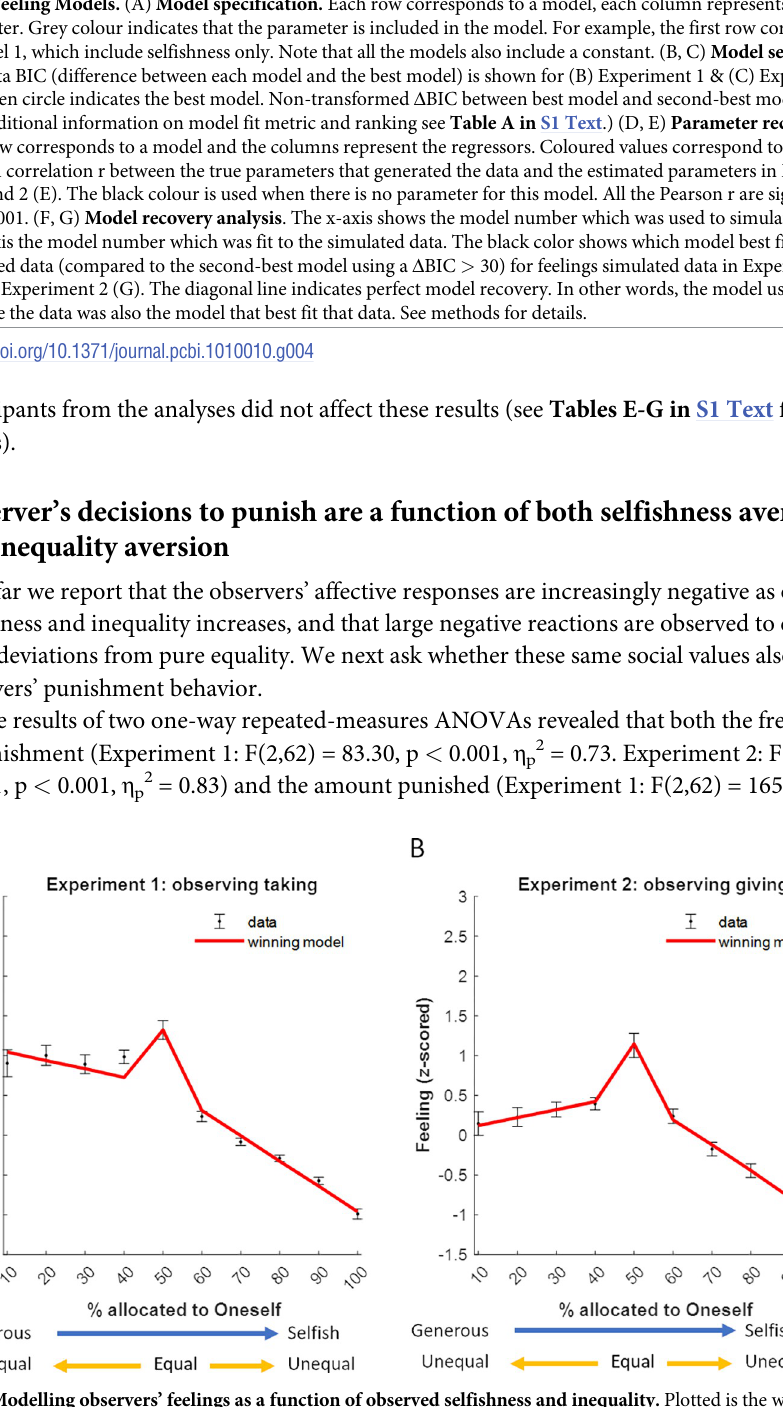
Fig 4. Feeling Models. (A) Model specification. Each row corresponds to a model, each column represents a parameter. Grey colour indicates that the parameter is included in the model. For example, the first row corresponds to model 1, which include selfishness only. Note that all the models also include a constant. (B, C) Model selection. Log delta BIC (difference between each model and the best model) is shown for (B) Experiment 1 & (C) Experiment 2. The green circle indicates the best model. Non-transformed Δ BIC between best model and second-best model > 50. (For additional information on model fit metric and ranking see Table A in S1 Text .) (D, E) Parameter recovery. Each row corresponds to a model and the columns represent the regressors. Coloured values correspond to the Pearson correlation r between the true parameters that generated the data and the estimated parameters in Experiment 1 (D) and 2 (E). The black colour is used when there is no parameter for this model. All the Pearson r are significant at p < 0.0001. (F, G) Model recovery analysis . The x-axis shows the model number which was used to simulate data and the y-axis the model number which was fit to the simulated data. The black color shows which model best fit the simulated data (compared to the second-best model using a Δ BIC > 30) for feelings simulated data in Experiment 1 (F) and Experiment 2 (G). The diagonal line indicates perfect model recovery. In other words, the model used to simulate the data was also the model that best fit that data. See methods for details.